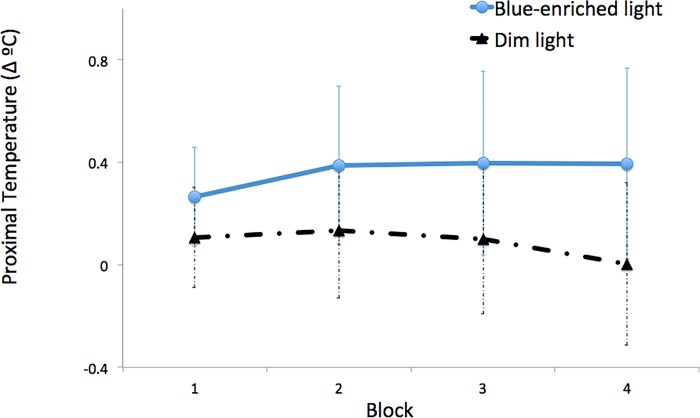
Variation in infraclavicular temperature with respect to baseline as a function of time on task (block) and lighting (blue thick line: blue-enriched light, black thin line: dim light).